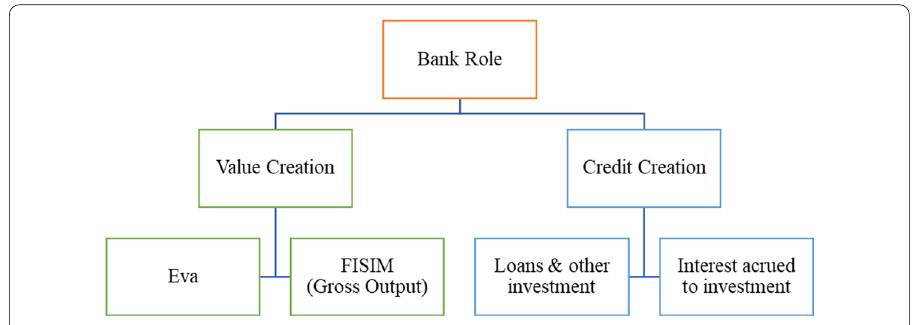
Fig. 1 Conceptual framework (source;